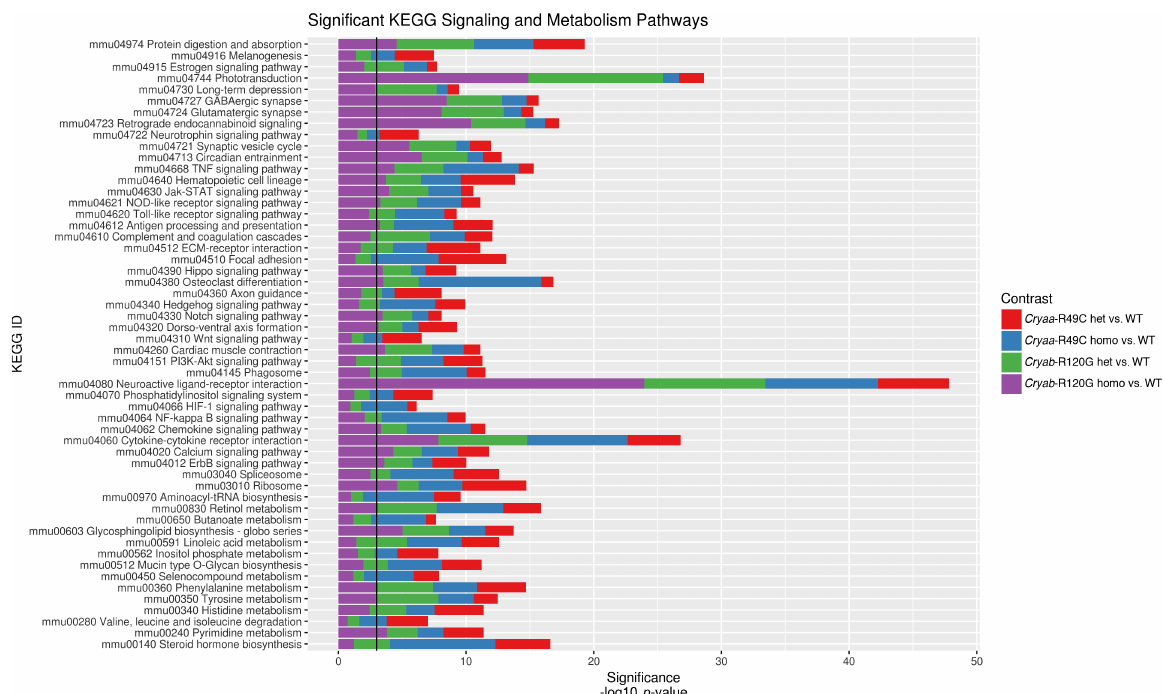
Fig 5. Barplot of significantly perturbed KEGG signaling and metabolism pathways across all four mutant genotypes. The statistical significanceshown on the x-axis has been–log10 scaled. Each pathway has 4 stacked bars showingthe significance(not the magnitude) of each pathway for each genotype. The p -valuecutoff of 0.05 is indicatedby the vertical black line, to differentiate pathways significantfor one genotypeversus the others.